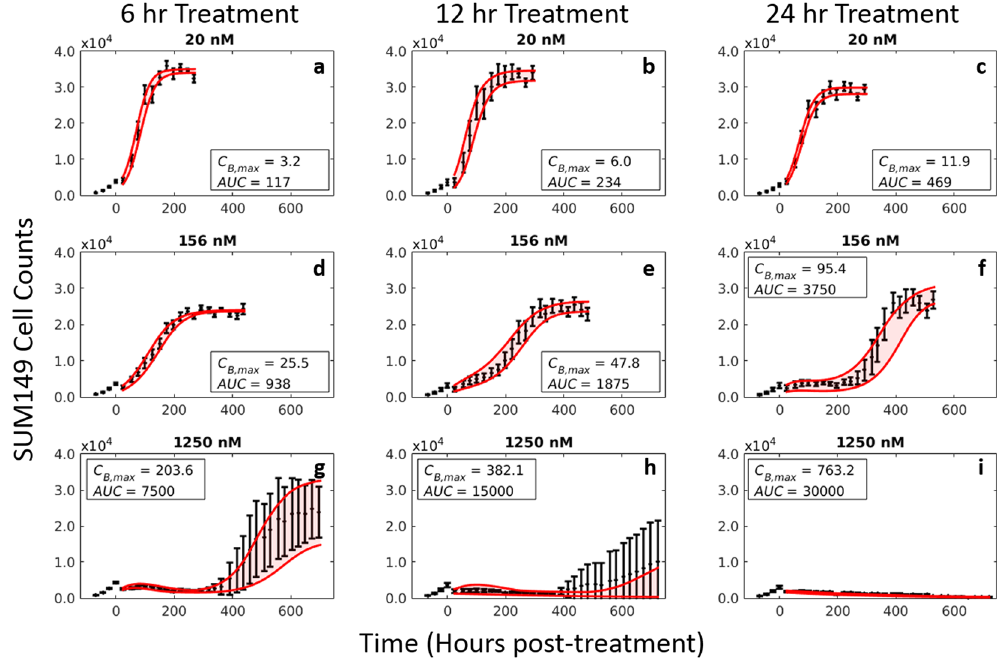
Figure 3. Impact of doxorubicin concentration and exposure time on response of SUM-149PT cells. The SUM-149PT cell line was plated and serially imaged via fluorescence microscopy for 30 days following time- resolved doxorubicin treatments. Nuclear counts from these images are displayed below in black with error bars representing the 95% CI from the six experimental replicates. These counts are fit to Eqs (4 and 5) as described Section 2.5. Model fits with 95% CI are superimposed on the cell counts. The SUM-149PT cell line demonstrated a graded dose-dependent and time-dependent response to doxorubicin treatment. At low concentrations, no appreciable treatment effect is noted regardless of exposure time ( a – c ). At higher concentrations and exposure times, the population growth rate slows ( d , e ), eventually demonstrating a prolonged response to therapy with subsequent regrowth of the population ( f – h ). At very high concentrations and exposure times, no population regrowth is observed ( i